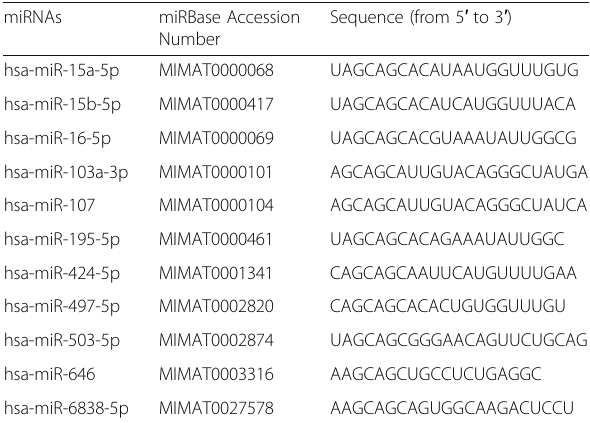
Table 1 The “ AGCAGC ” sequence for evolutionarily conservative miR-15/107 family miRNAs miRBase Accession Sequence (from 5 ′ to 3 ′ ) Number